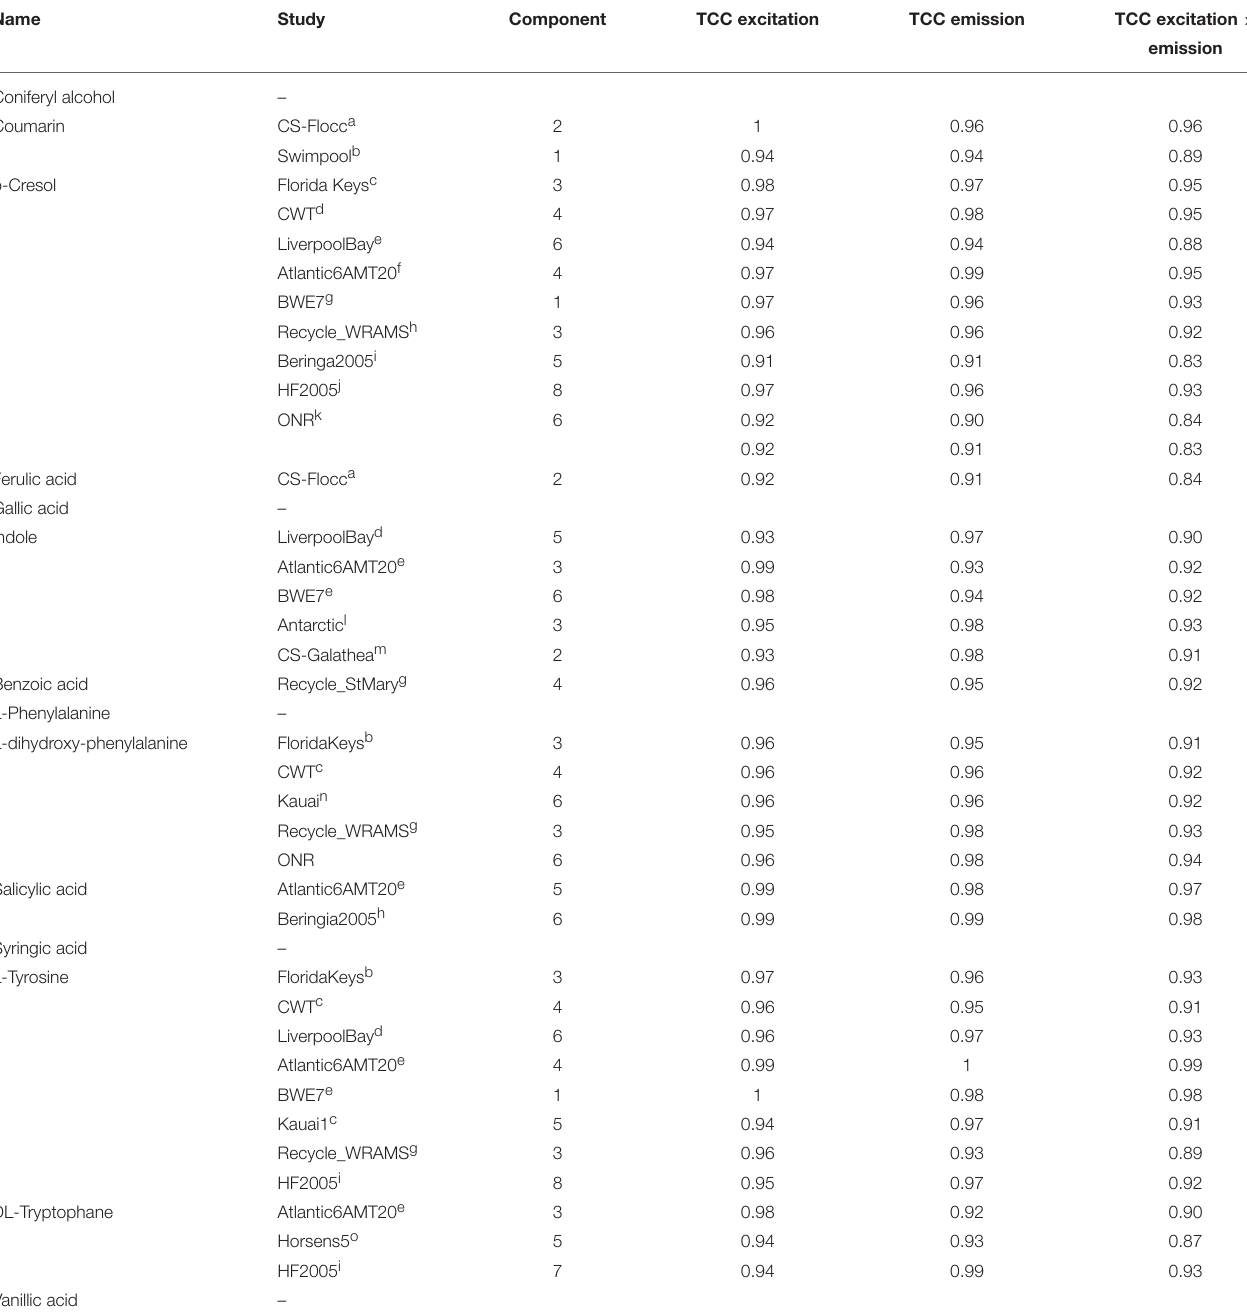
TABLE 2 | Similarities between fluorescence spectra of PARAFAC components in the OpenFluor database and the spectra of organic